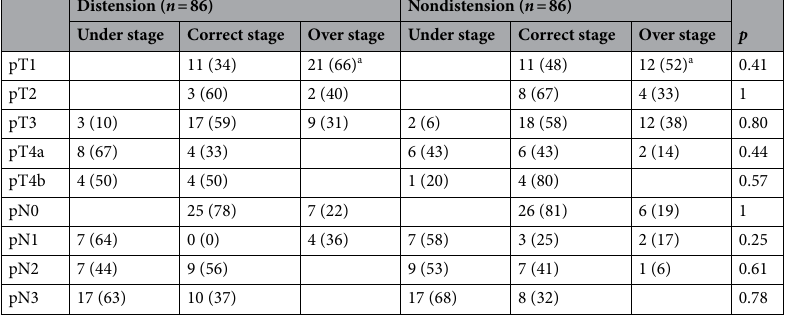
Table 5. Clinical versus pathological TN staging concordance. Data presented as counts and percentages in parenthesis. a In over staged pT1 lesions, 24% (5/21) in Distension group and 42% (5/12) in Nondistension group were over staged by two levels ( p =